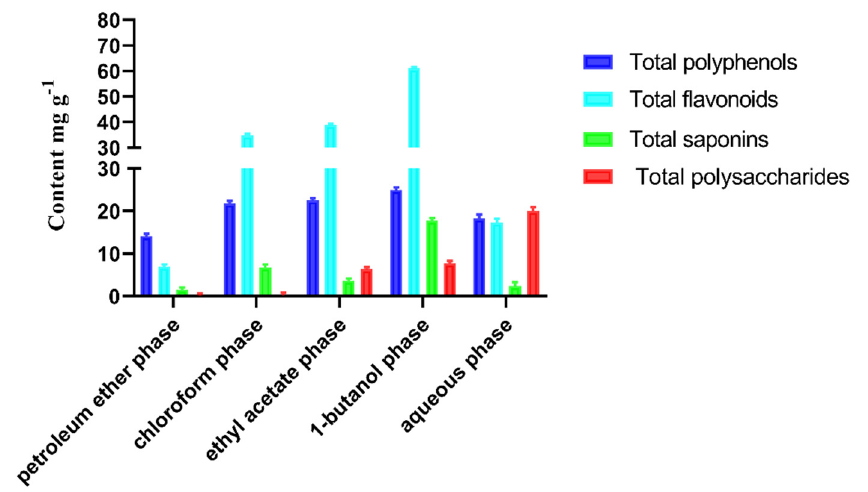
Figure 3. Contents of the active components in the different